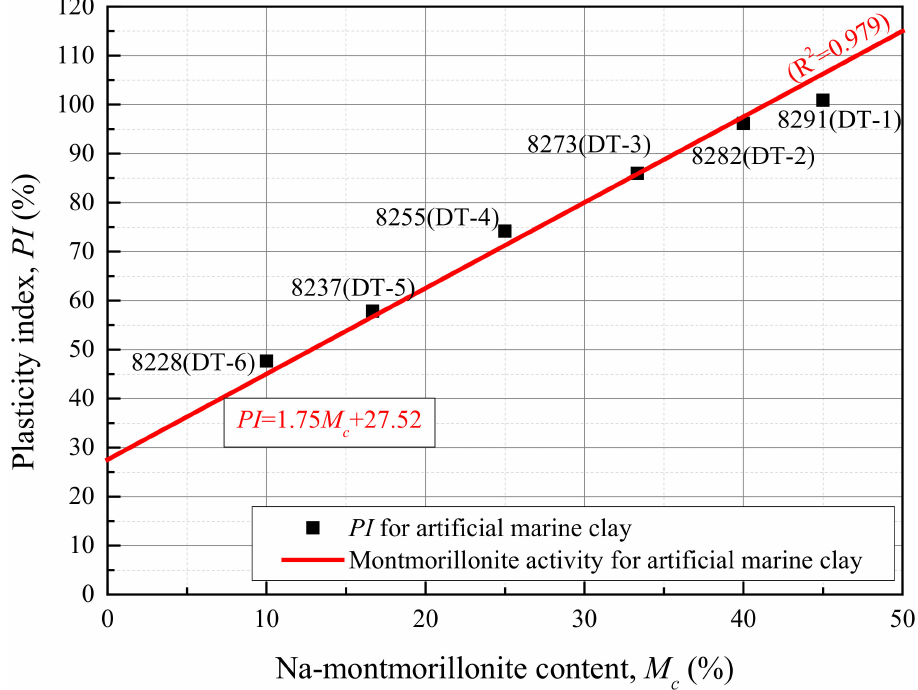
Figure 3. Relationship between Na-montmorillonite content and plasticity index ( PI ) in artificial marine